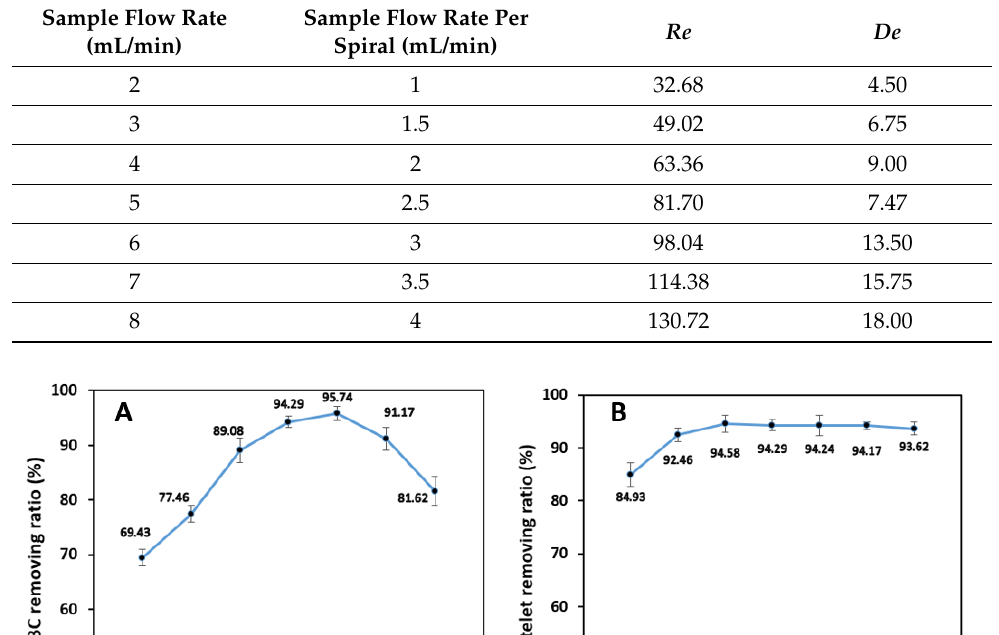
Table 1. The microchip’s specifications in terms of sample flow rate, microchannel Reynolds num- ber, and Dean number.